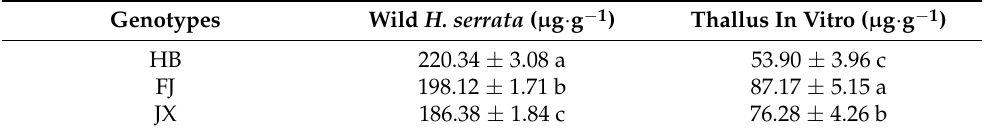
Table 5. Hup A content in different H. serrata .